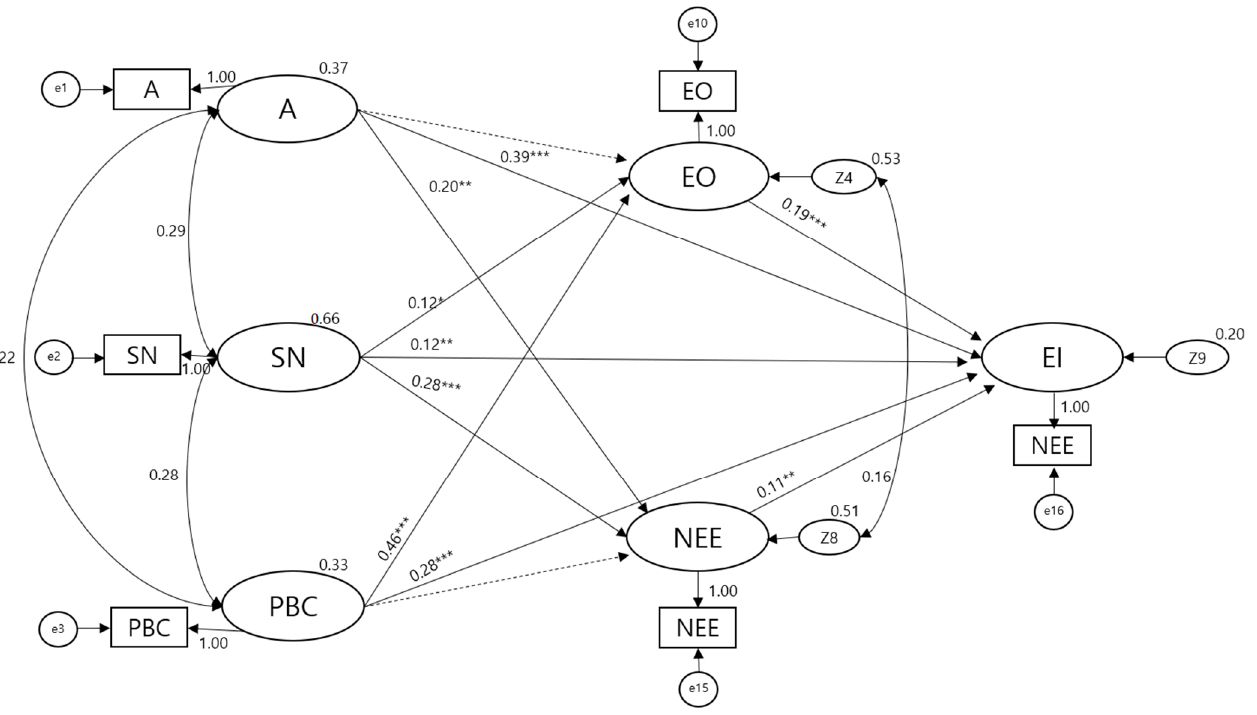
Figure 4. Modified Model 3 of this study. A, attitude; SN, subjective norm; PBC, perceived behavior control; EO, entrepreneurial orientation; NEE, need for entrepreneurship education; EI, entrepreneurial intention. *** p < 0.001, ** p < 0.01, * p < 0.05.